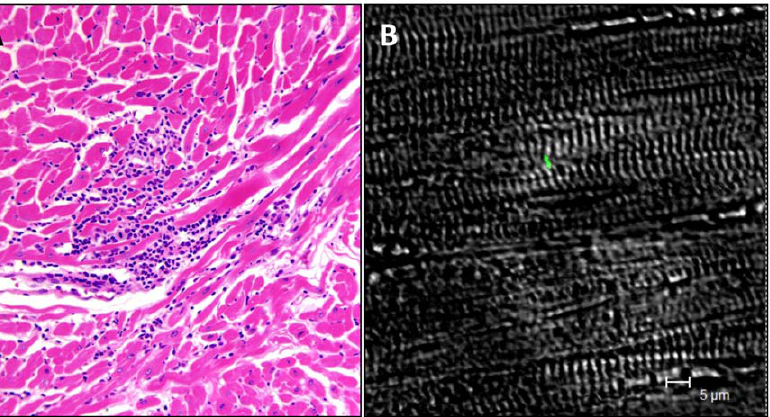
Figure 3. Images of tissue inflammation and B.burgdorferi antigen in tissues from animals treated in the late, disseminated phase (Experiment 1). For antigen detection, samples of tissue were stained for fluorescent detection (IFA) with anti- B. burgdorferi monoclonal (see Materials and Methods) antibody. (A) Hematoxylin &Eosin stain showing monocytic and lymphocytic infiltrate in a heart section (20 6 ) of a treated animal (AM38). (B) Image of positive IFA staining from the heart tissue of the same